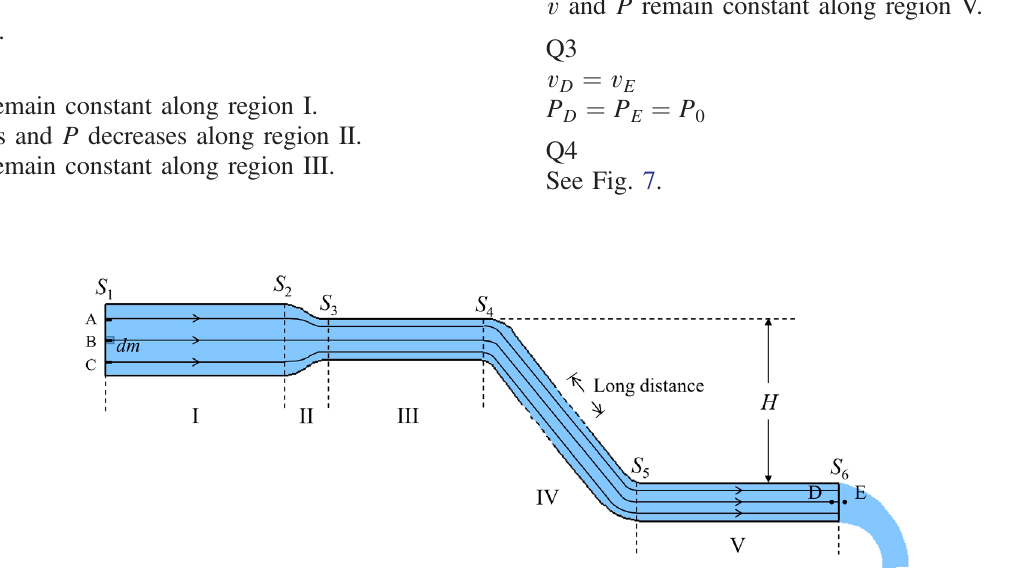
FIG. 6. Streamlines of the water flow in different